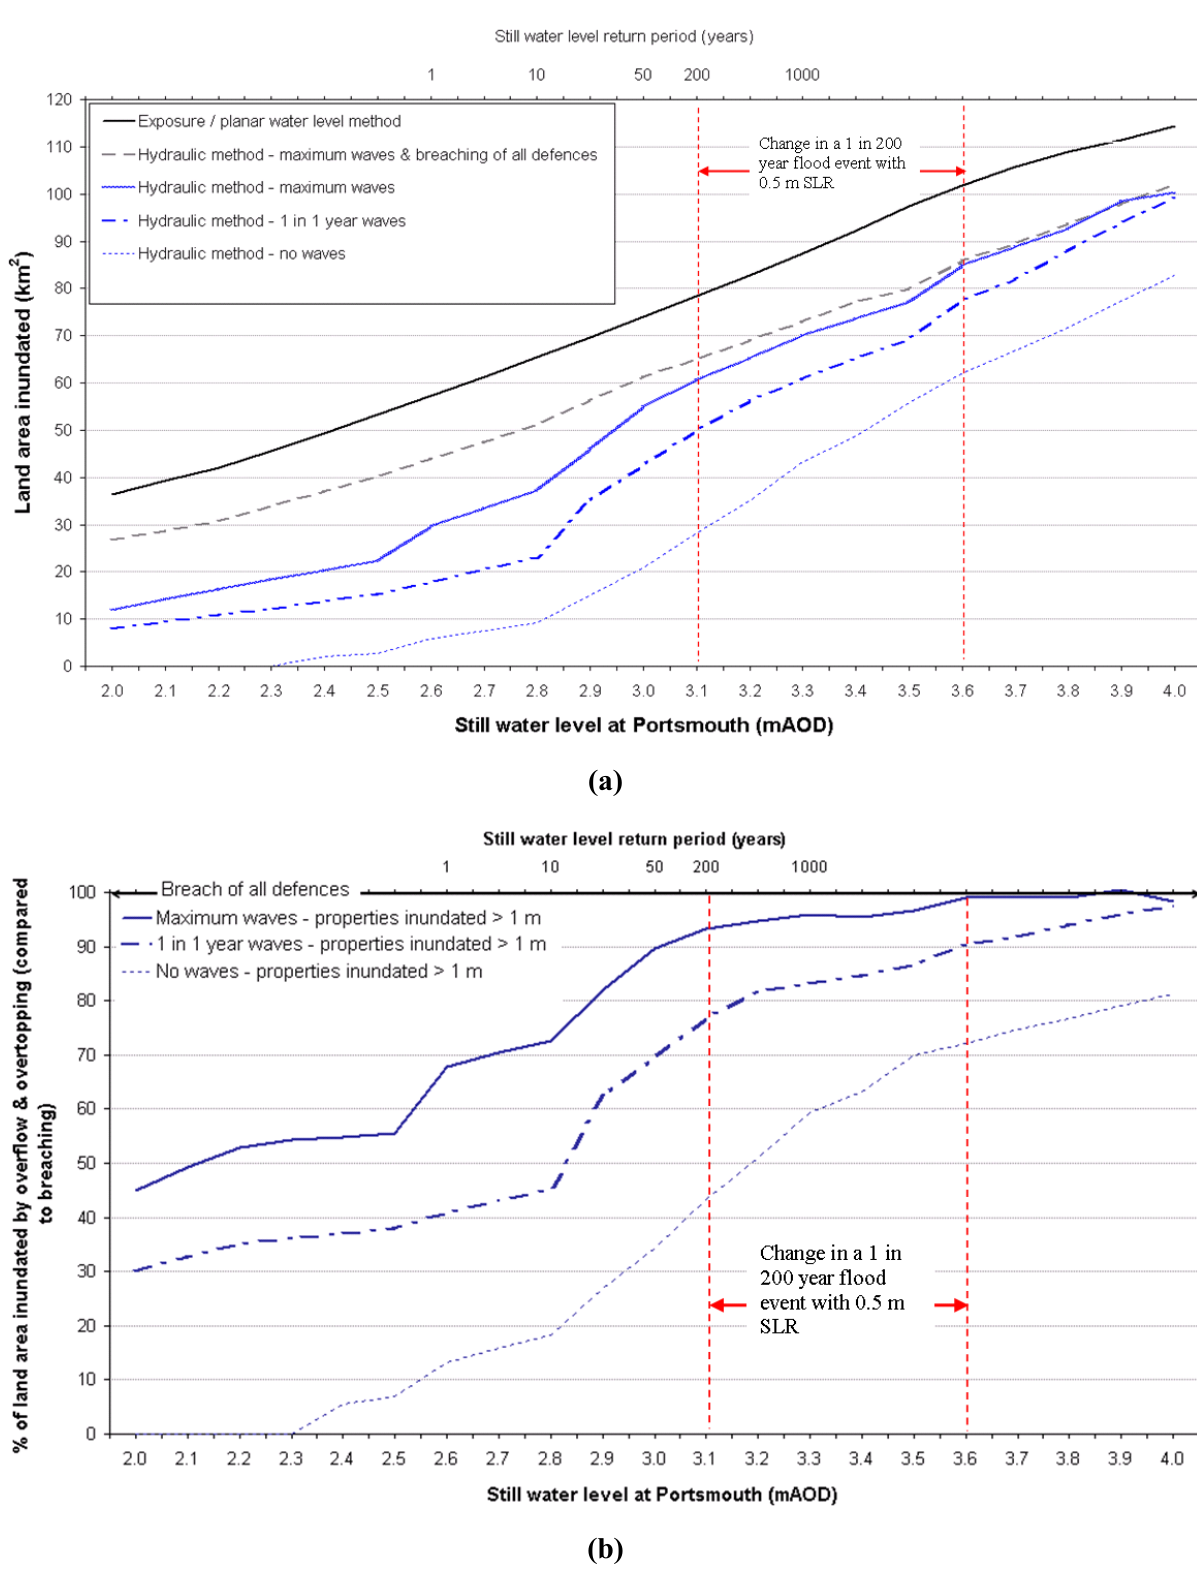
Figure 11. ( a ) Coastal flood modelling results across the Solent by land area; ( b ) Percentage of land area inundated by overflow and overtopping defence failures (compared to breach of all